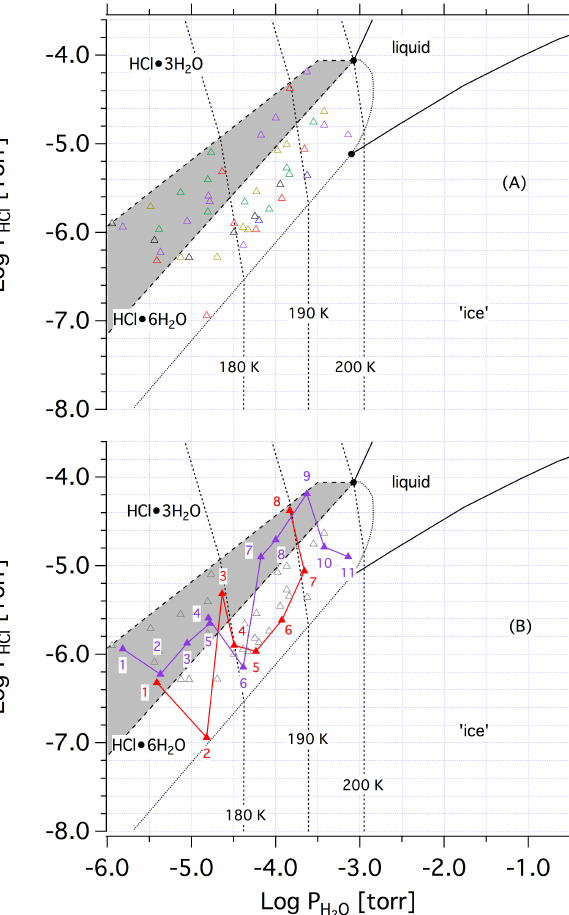
Figure 9. Phase diagram of the HCl/H 2 O system reconstructed from Hanson and Mauersberger, 1990. The empty coloured trian- Mauersberger, 1990. The empty coloured triangles represent calculated values of 1243 gles represent calculated values of P eq (HCl) and P eq (H 2 O) for HH P eq (HCl) and P eq (H 2 O) for HH using the kinetic results for adsorption and desorption 1244 using the kinetic results for adsorption and desorption of H 2 O and HCl of the present work, according to Eq. (11). Different colours of H 2 O and HCl of the present work, according to equation 22. Different colours 1245 represent different experiment series. The shaded area is the pro- represent different experiment series. The shaded area is the proposed extension of the 1246 posed extension of the HH existence area according to the results of HH existence area according to the results of the present work with both quadruple 1247 the present work with both quadruple points preserved. (B) Two dif- ferent experiment series where the temporal evolution of the sample points preserved. Panel (B) shows two different experiment series where the temporal 1248 is discussed. Details may be found in the evolution of the sample is discussed. Details may be found in the text. 1249 1250